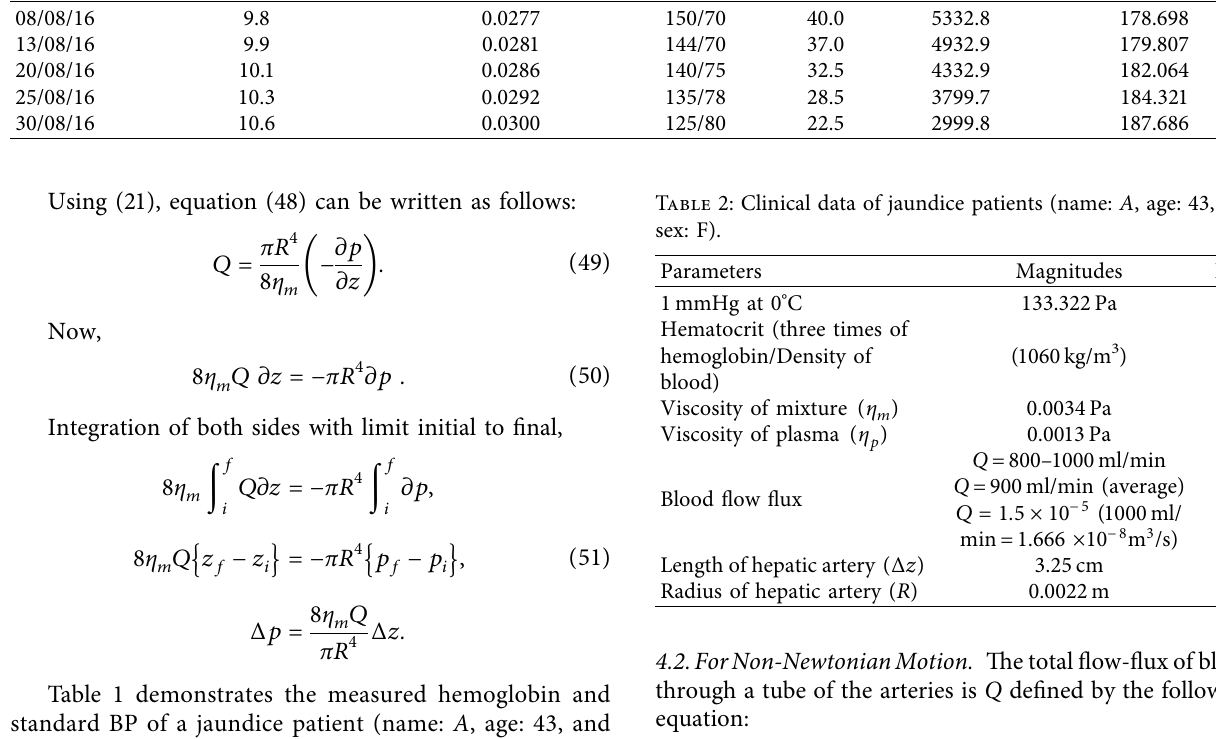
Table 1: Clinical data and calculated BP values of jaundice patient (name: A , age: 43, and sex: F). Date